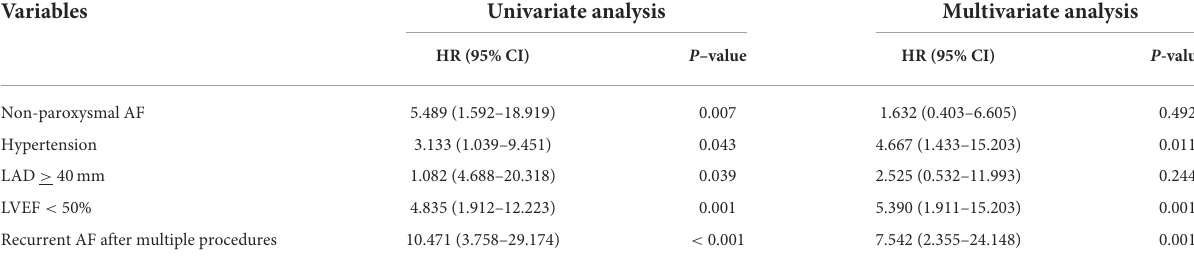
TABLE 4 Univariate and multivariate analyses for risk factors of the composite